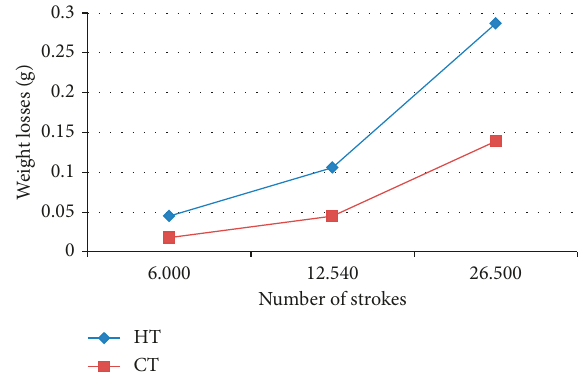
Figure 9: Weight loss and number of strokes (slot punch 10.5 × 8.5 × 100mm in